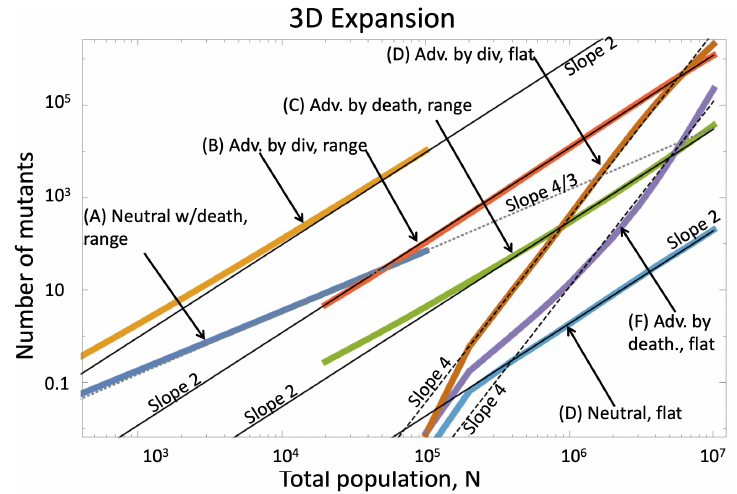
Figure 7. Mutants in the 3D expansion: the average number of mutants is plotted as a function of the total population. (A) Neutral mutants in a range expansion, with the corresponding dotted gray guide to the eye with slope 4/3 in the log–log plot. (B,C) Advantageous mutants in a range expansion, and the solid lines are guides to the eye with slope 2. (D) Neutral mutants in a 3D flat front expansion, and the solid guide to the eye has slope 2. (E,F) Advantageous mutants in a colony with a 3D flat expansion; the dashed guides to the eye have slope 4. Curve parameters are given in Table 4. Table 4. Simulation parameters for Figure